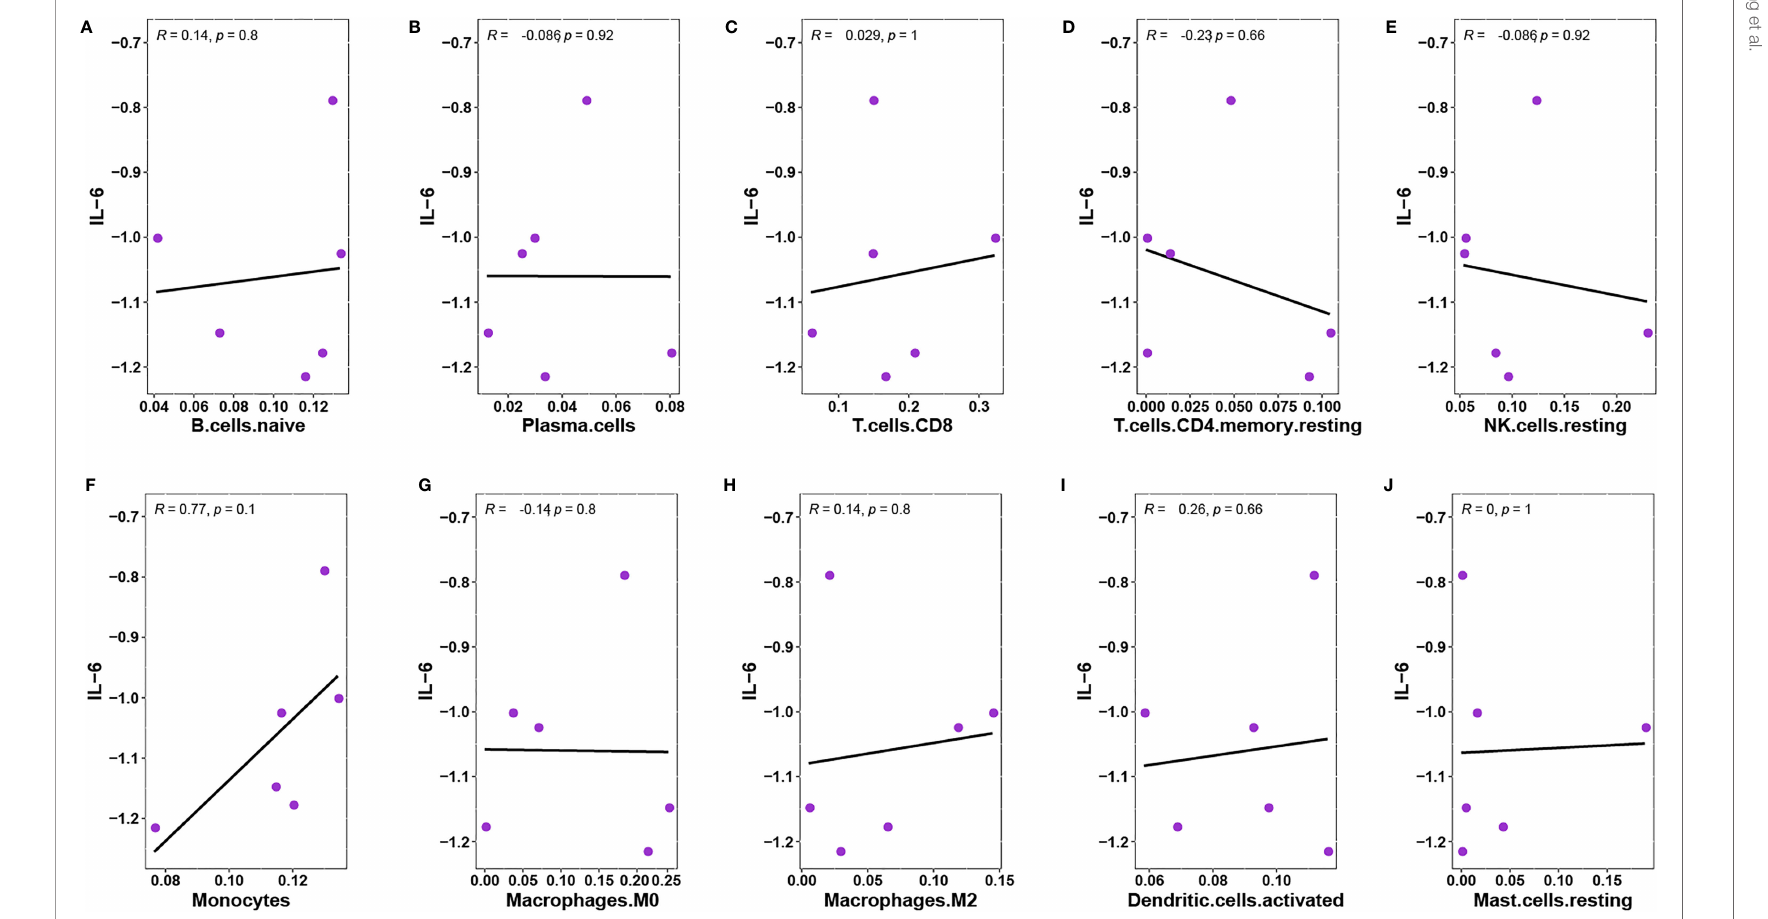
FIGURE 11 | (A) Pearson ’ s correlation between IL-6 and B.cells.naive. (B) Pearson ’ s correlation between IL-6 and Plasma.cells. (C) Pearson ’ s correlation between IL-6 and T.cells.CD8. (D) Pearson ’ s correlation between IL-6 and T.cells.CD4.memory.resting. (E) Pearson ’ s correlation between IL-6 and NK.cells.resting. (F) Pearson ’ s correlation between IL-6 and Monocytes. (G) Pearson ’ s correlation between IL-6 and Macrophages.M0. (H) Pearson ’ s correlation between IL-6 and Macrophages.M2. (I) Pearson ’ s correlation between IL-6 and Dendritic.cells.activated. (J) Pearson ’ s correlation between IL-6 and